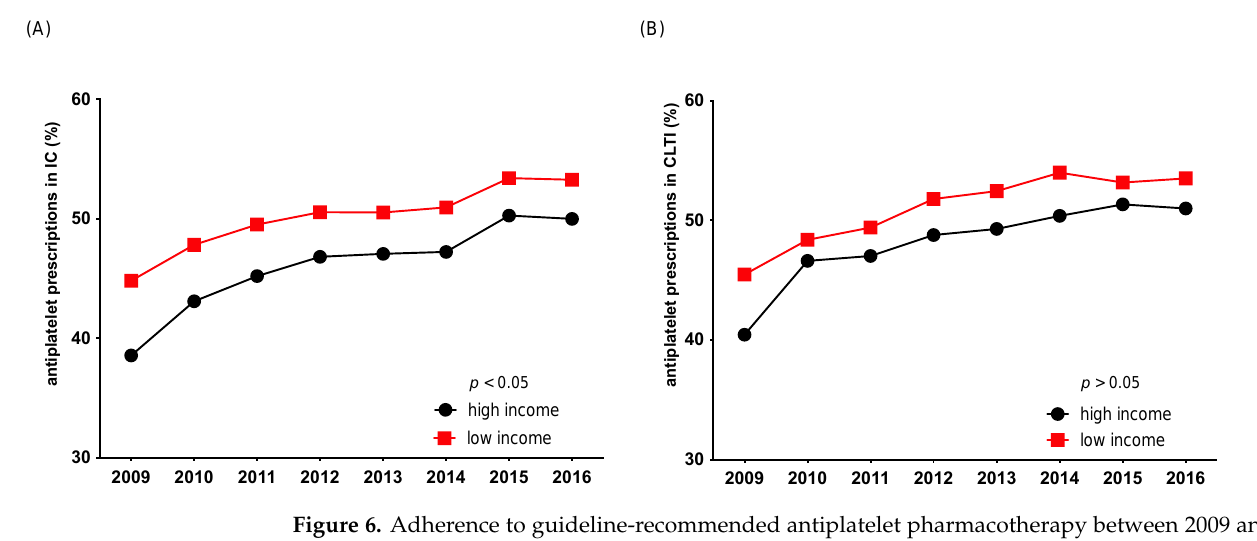
Figure 5. Adherence to guideline-recommended statin pharmacotherapy between 2009 and 2016, stratified by income level and stage of disease: intermittent claudication (IC) ( A ), critical limb-threat- ening ischemia (CLTI) ( B ).